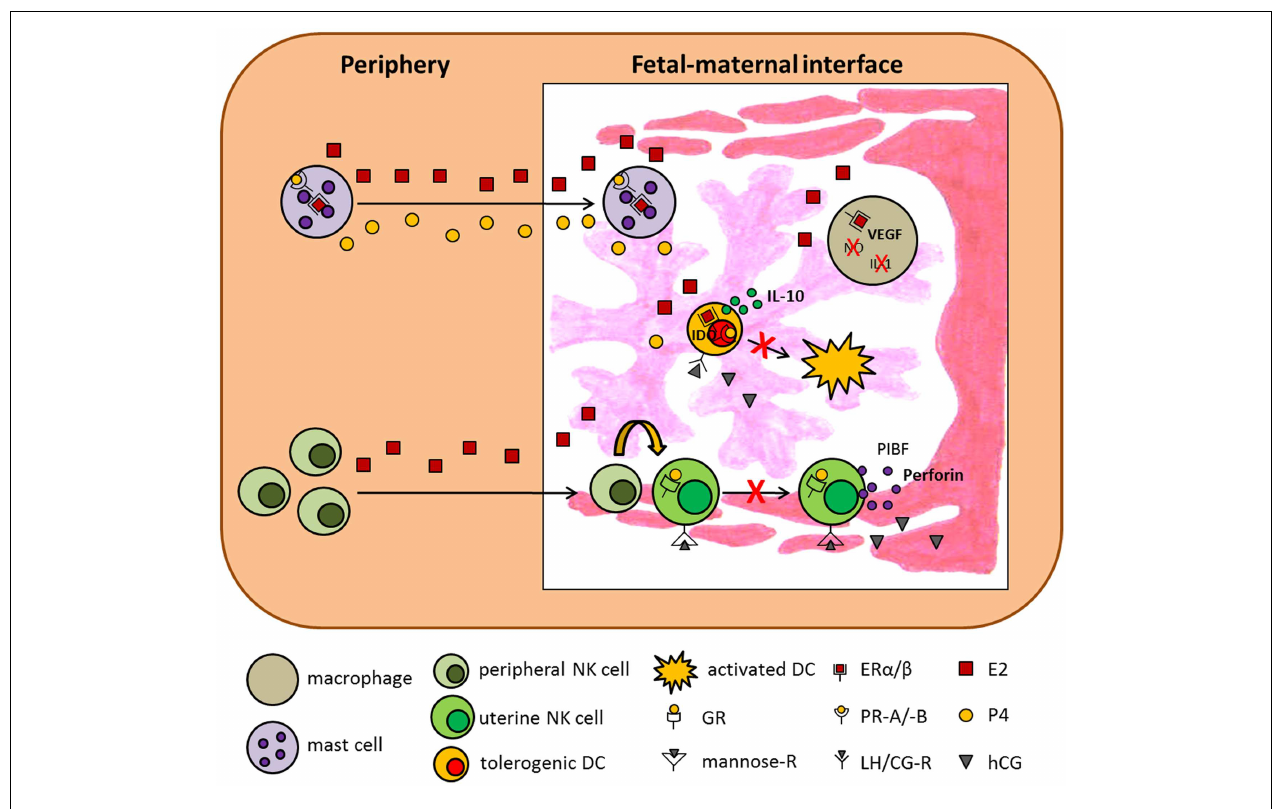
GR, glucocorticoid receptor; IDO, indoleamine 2,3-dioxygenase; IL-1, interleukin-1; IL-10, interleukin-10; LH/CG-R, luteinizing hormone/chorionic gonadotropin receptor; NO, nitric oxide; PIBF, progesterone-induced blocking factor; PR, progesterone receptor;VEGF, vascular endothelial growth